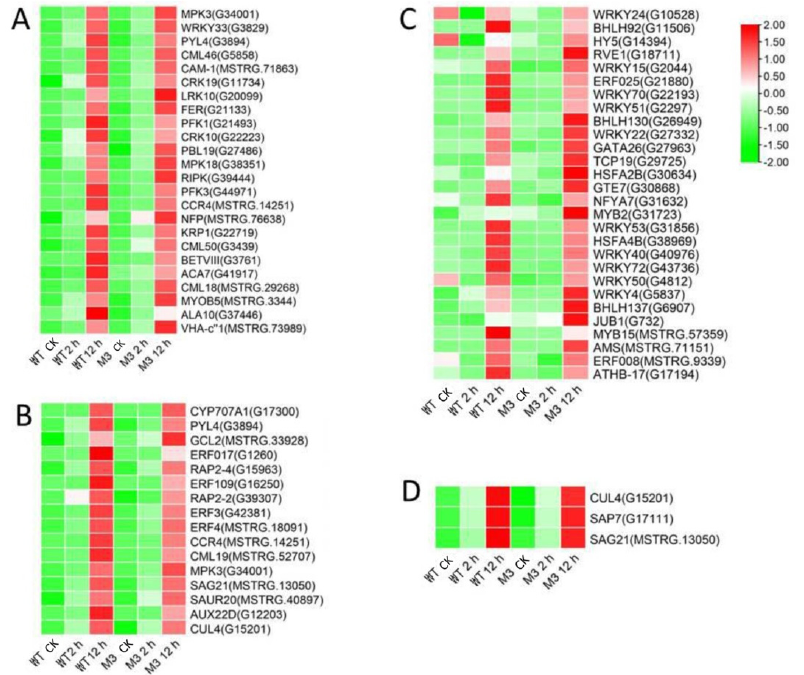
Figure 6. Heatmap of common DEGs involved in Profile 7 in both WT and M3 plants. ( A ) Protein kinase and Ca 2+ signal-related genes, ( B ) hormone-related genes, ( C ) transcription factors, and ( D ) stress-related genes were identified. The sample and treatments are displayed at the bottom of each column. Relative expression levels are shown by a colored gradient, from low (green) to high (red). Scale bars represent the log 2 transformations of the RPKM values.